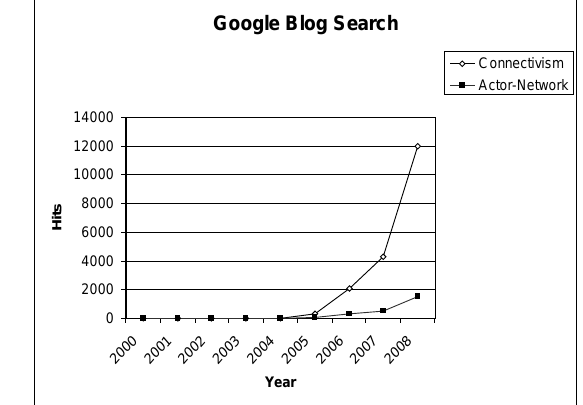
Figure 3 . Search of Google Scholar for connectivism and actor-network theory.